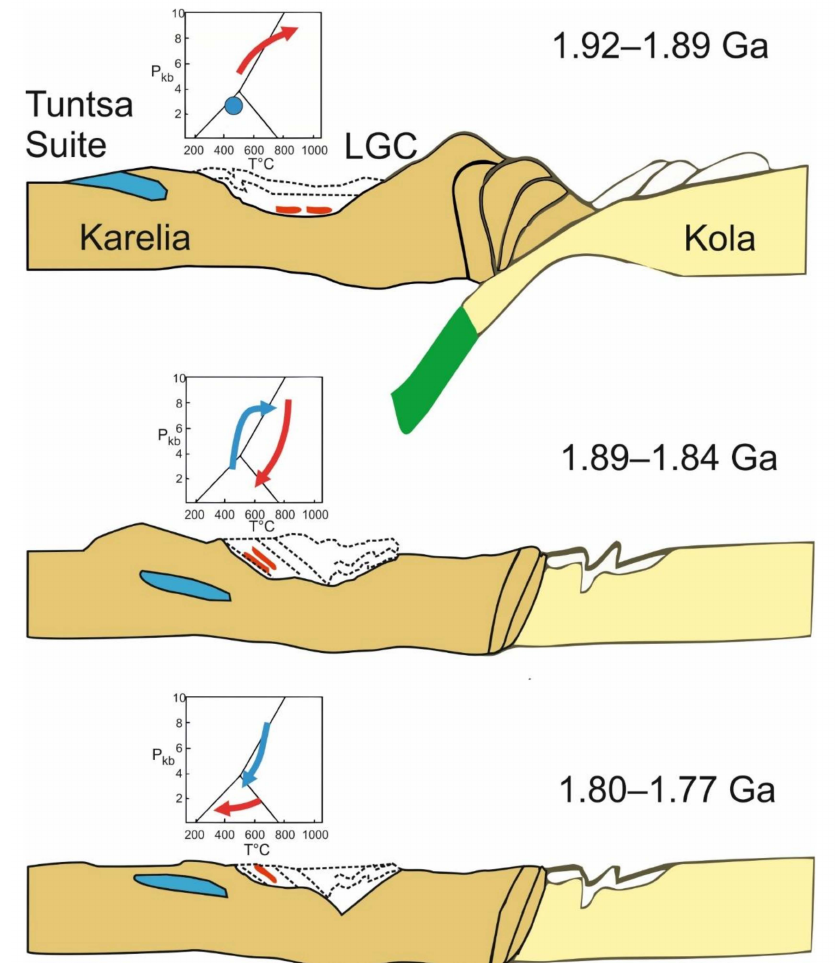
Figure 13. A cartoon illustrating the tectonic development of the Tuntsa suite as a function of time, modified from Lahtinen and Huhma [9]. LGC = Lapland Granulite Complex. The blue dot and arrow in the PT diagram illustrate the PT path of the Tuntsa Suite and the red arrow that of the